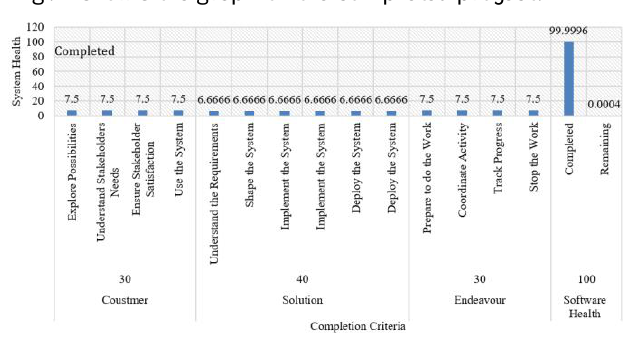
Fig. 5. Software Health after Explore Possibilities achieved Fig. 5 shows that only one activity space that is Explore possibilities having 7.5% of totals software health is achieved. Furthermore, it shows that 92.5% of work is remaining to complete the project. Similarly, Fig. 6 shows the results when all activity spaces were achieved present in the customer area of concern and Fig. 7 shows the graph of the completed project.